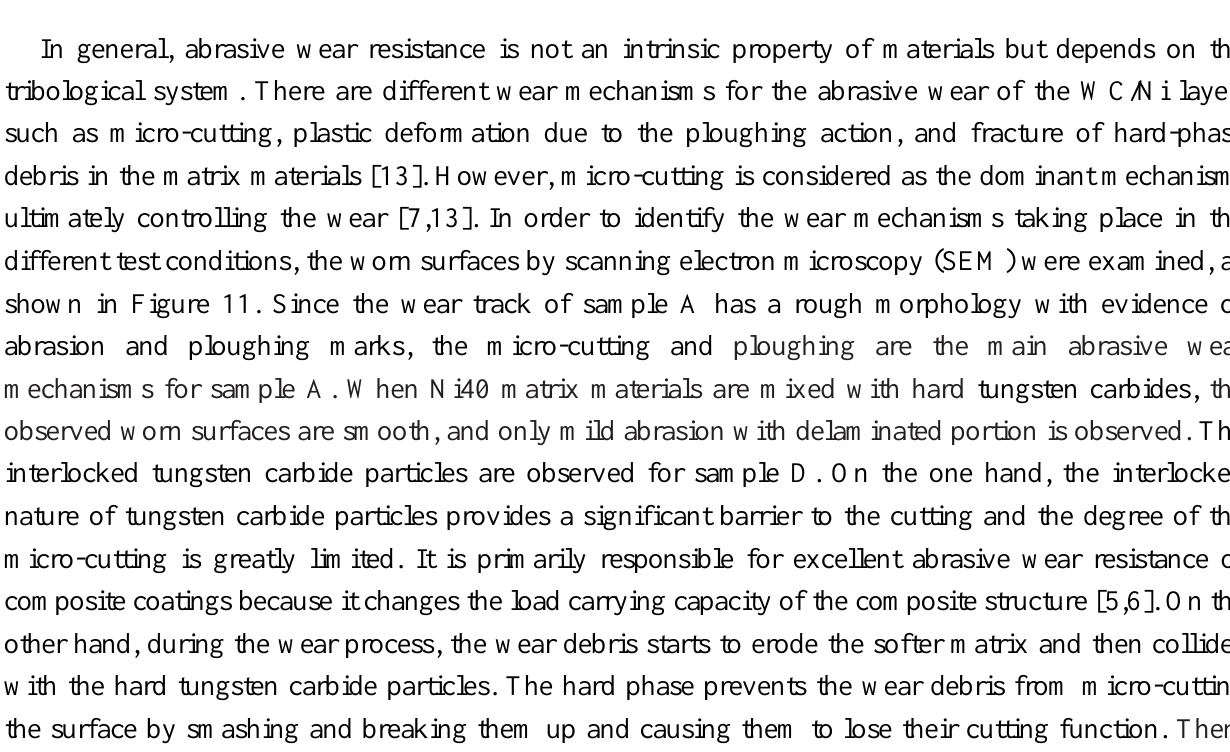
Figure 10. Mass loss of the coatings with different test